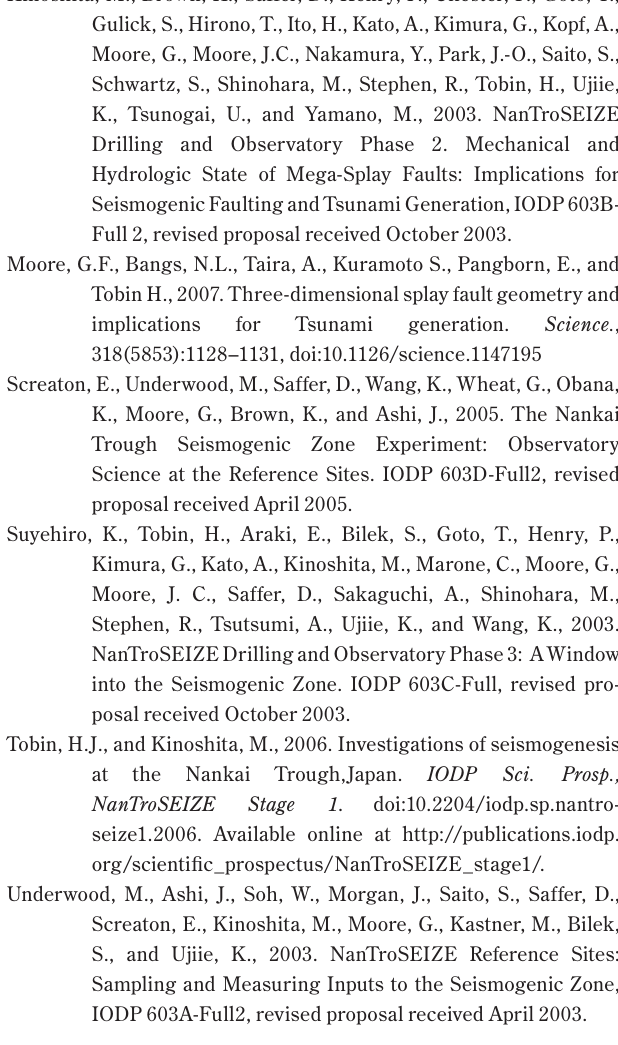
All photos courtesy of IODP and CDEX.